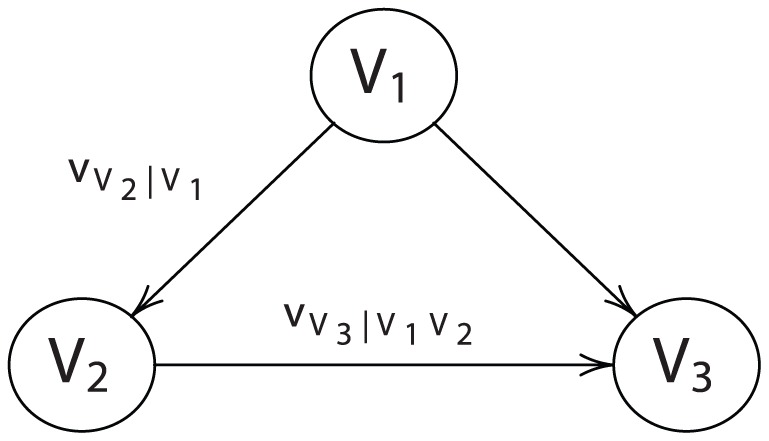
A three-vertex DAG.